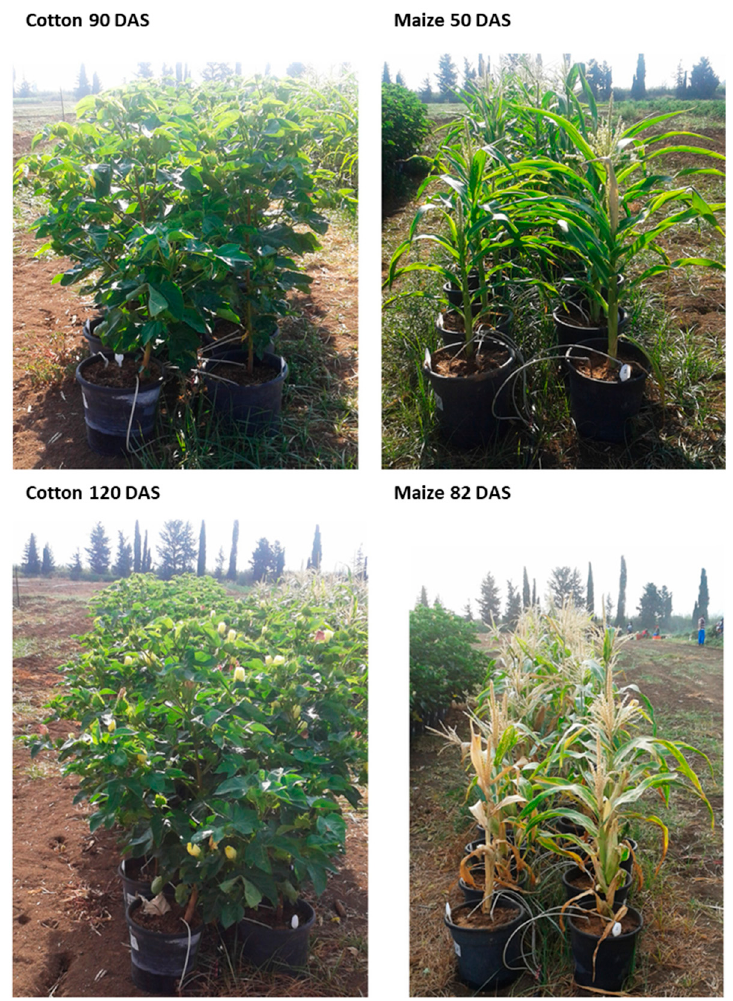
Figure 6. Photograph of the maize and cotton plants in the 2018 experiment. The experiment at the vegetative growth stage, 50 and 90 DAS in maize and cotton, respectively (upper panels), and at the end of the season, 82 and 120 DAF in maize and cotton, respectively (lower panels).